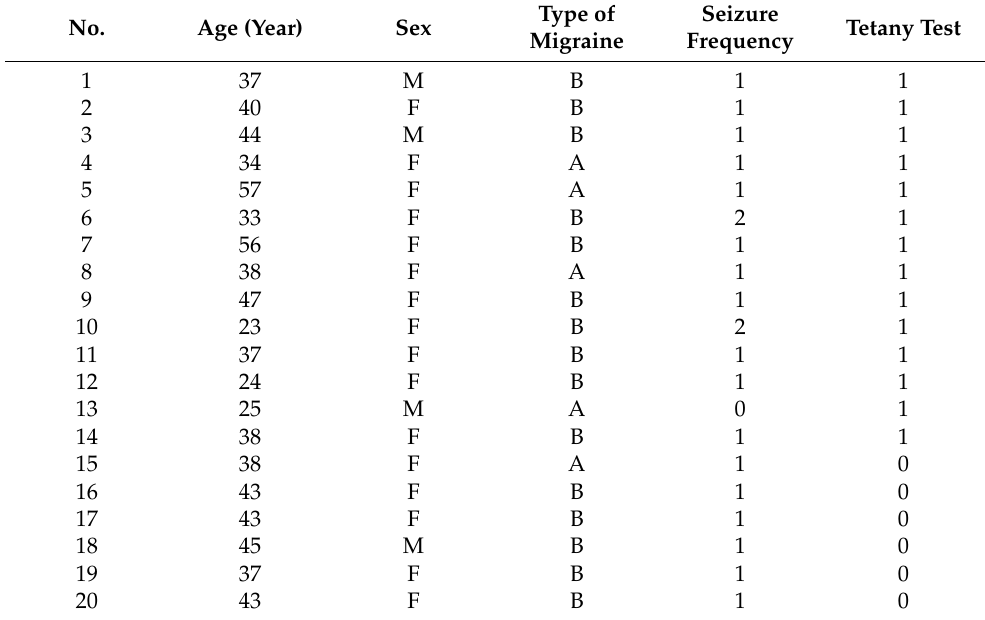
Table 1. Demographic data, migraine clinical data and the results of the tetany test in the study group (with migraine n = 35). Sex: F—female, M—male. Type of migraine: A—migraine with aura, B—migraine without aura. Seizure frequency: 0—rare seizurese <1/month, 1—seizures